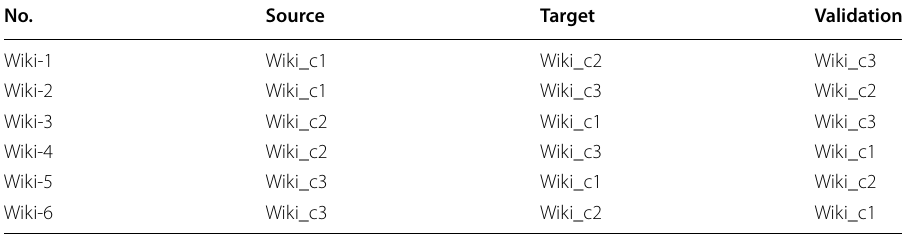
Table 2 Wikipedia datasets No.